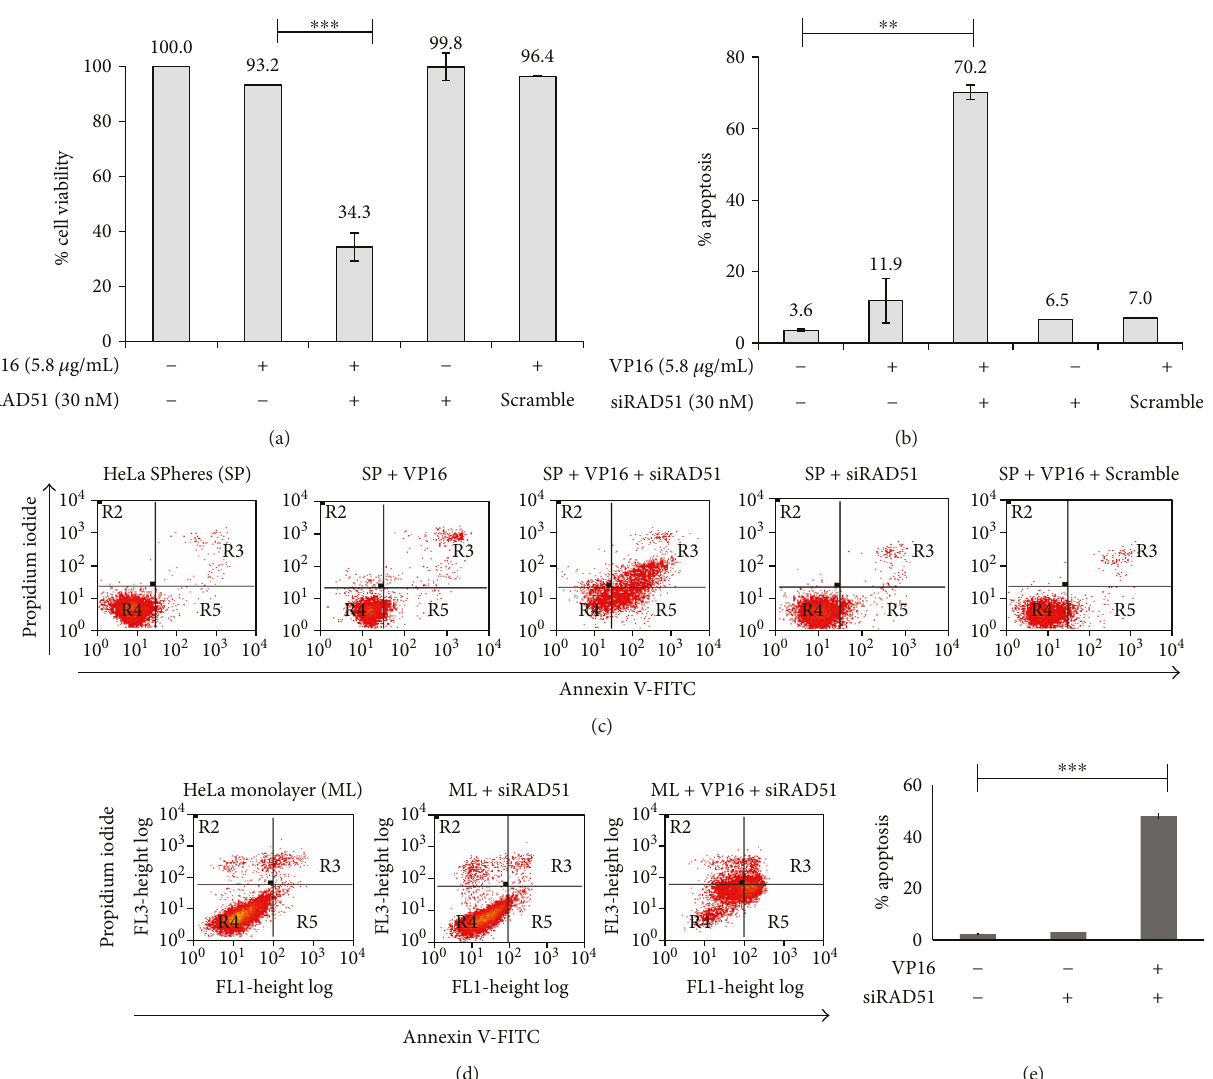
Figure 4: Inhibition of RAD51 expression and Etoposide induces apoptosis in sphere cultures. (a) HeLa SPhere culture was exposed to 30 nM of siRAD51 and 5.8 μ g/mL of VP16. By MTT assay, cell viability was a ff ected in the presence of both compounds, but not when they were added independently. The absence of RAD51 protein decreased the cell viability of spheres exposed to VP16. HeLa SP culture exposed to VP16 and 30 nM of random siRNA (scrambled) was used as control. (b and c) Apoptosis was evaluated by Annexin-V assay (see Materials and Methods) under identical conditions; the highest level of apoptosis was exhibited in the presence of both VP16 and siRAD51. The absence of RAD51 protein sensitized spheres to VP16. (d and e) Control indicating that treatment with siRAD51 and Etoposide induces apoptosis in ML cells. ∗∗ p < 0 01 and ∗∗∗ p < 0 001